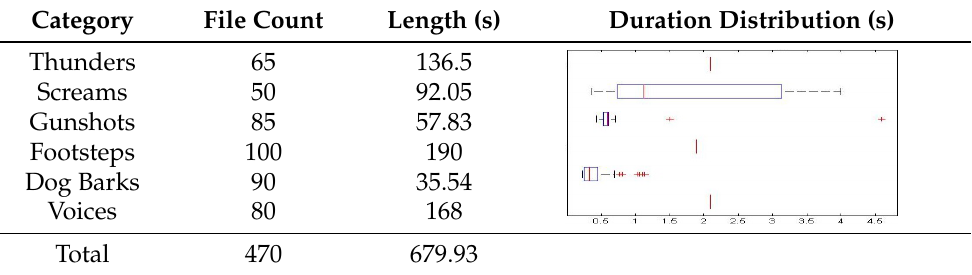
Table 4. Surveillance-related corpus composition [49].